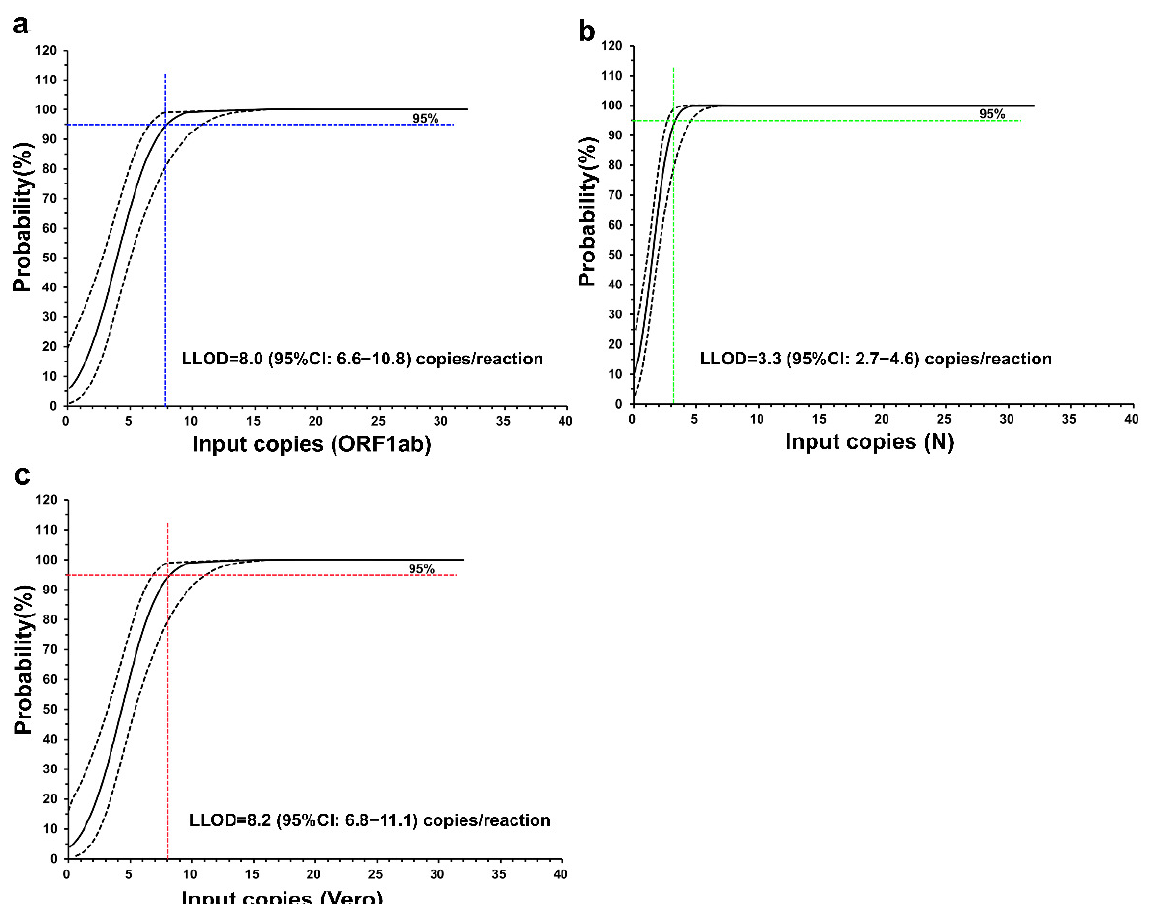
Figure 3. The LLOD of the novel RT-qPCR. ( a ) The probability of detecting the ORF1ab gene (%) at a ratio of 1:2 in serial dilutions of standards from 32 to 1 input copy/reaction using probit regression (solid black line; dashed line denotes the 95% CI). The LLOD, defined as the concentration of the ORF1ab gene in a reaction where the probability of detection in the assay was 95%, was interpolated from the probit curve and is shown as a coloured dashed line; ( b ) the probability of detecting the N gene (%) at a ratio of 1:2 in serial dilutions of standards from 32 to 1 input copy/reaction using probit regression (solid black line; dashed line denotes the 95% CI); ( c ) the probability of detecting the Vero gene (%) at a ratio of 1:2 in serial dilutions of standards from 32 to 1 input copy/reaction using probit regression (solid black line; dashed line denotes the 95% CI).